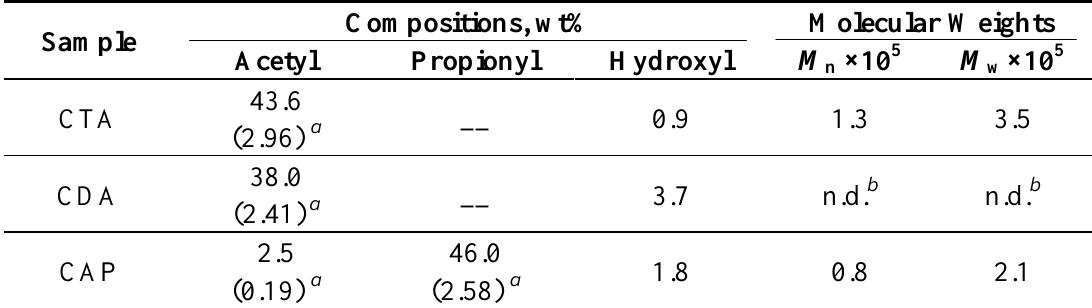
Table 1. Characteristics of